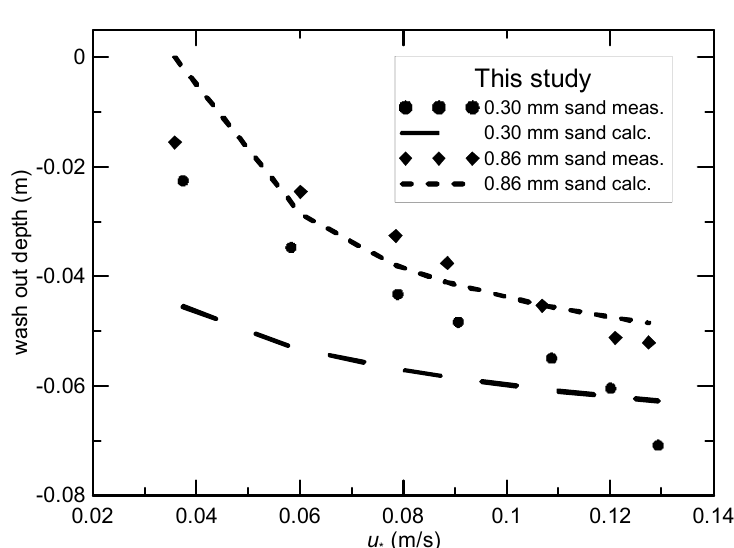
Fig. 4 Measured washout depths from the experiments and calculated values from equations (7) and